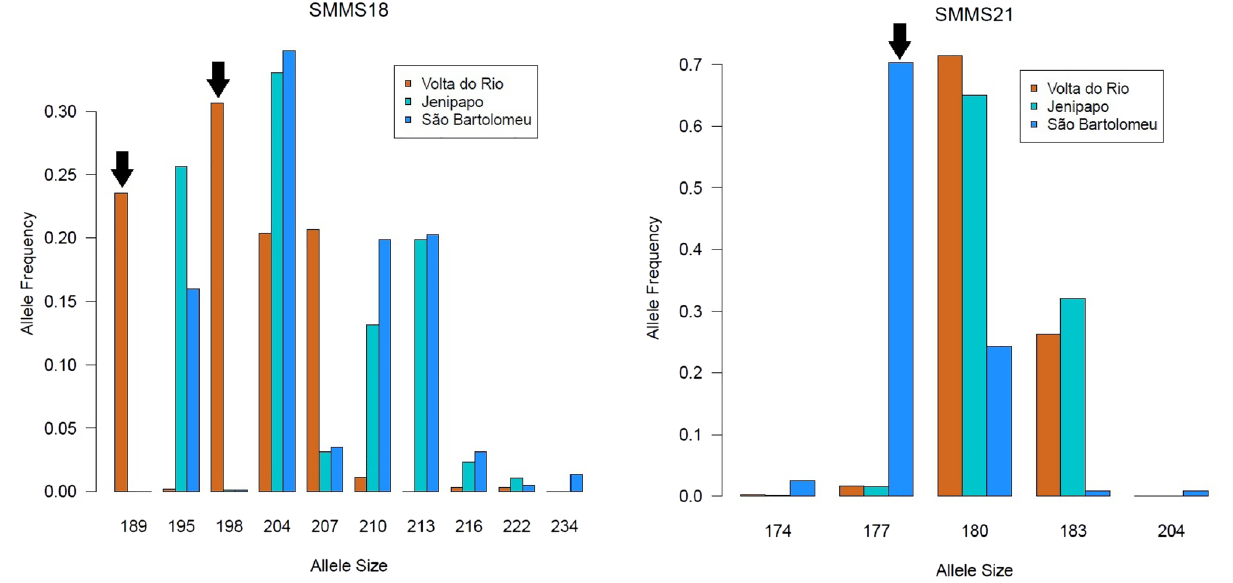
Figure 1. Two examples of loci with alleles that reach a high frequency in one community while being rare or absent in the other communities. Arrows point to the diagnostic markers. At SMMS18 the 189 and 198 base- pair alleles are clear markers of infrapopulations sampled in the Volta do Rio community. The 177 base-pair allele at SMMS21 is a clear marker of infrapopulations sampled in the São Bartolomeu Nei’s gene identity coefficients 17,18 vary greatly by infrapopulation and by locus. Table 1 shows gene identity coefficients for the loci individually at three levels of population structure: allele frequencies within infrapopu- lations ( J S ), allele frequencies within communities ( J C ), and allele frequencies in the total population of three communities ( J T ). The locus-specific gene identity for the total population ( J T ) ranges from 0.147 to 0.677, with an average of 0.302. For communities ( J C ), the locus specific gene identities increase with a range of 0.152–0.678 with an average of 0.331. The locus-specific gene identity of infrapopulations ( J S ) within communities is the highest with a range of 0.169–0.696 with an average of 0.352. Focusing on gene identity in the individual infrapopulations reveals substantial variation, even for infra- populations in the same community. The range of gene identity among infrapopulations in São Bartolomeu is [0.321–0.493] with a mean of 0.352. In Jenipapo, the range of gene identity among infrapopulations is [0.307–0.441] with a mean of 0.348. The range of gene identity among infrapopulations in Volta do Rio, is